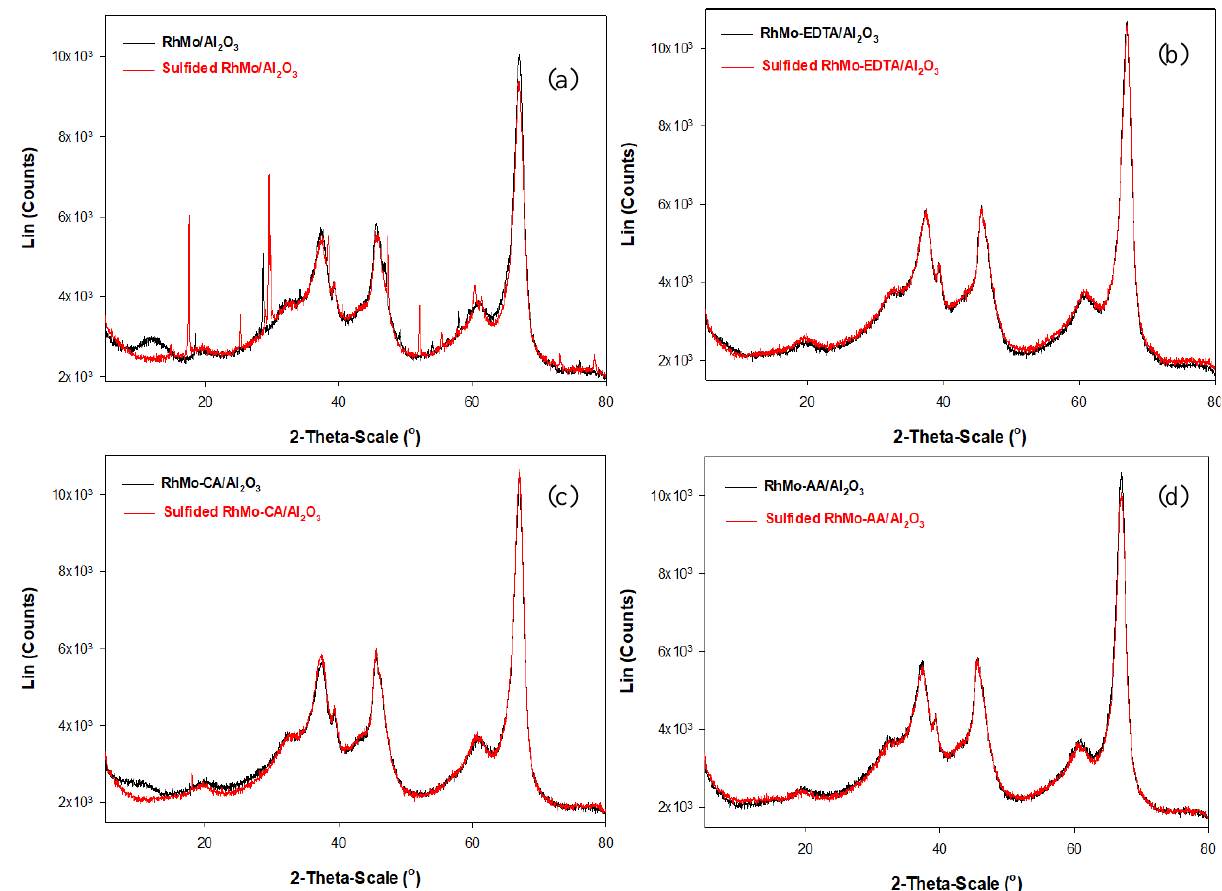
Figure 2. XRD diffraction pattern for oxide and sulfided ( a ) RhMo/ ɣ -Al 2 O 3 , ( b ) RhMo-EDTA/ ɣ -Al 2 O 3 , ( c ) RhMo-AA/ ɣ -Al 2 O 3 , ( d ) RhMo-CA/ ɣ -Al 2 O 3 catalysts.